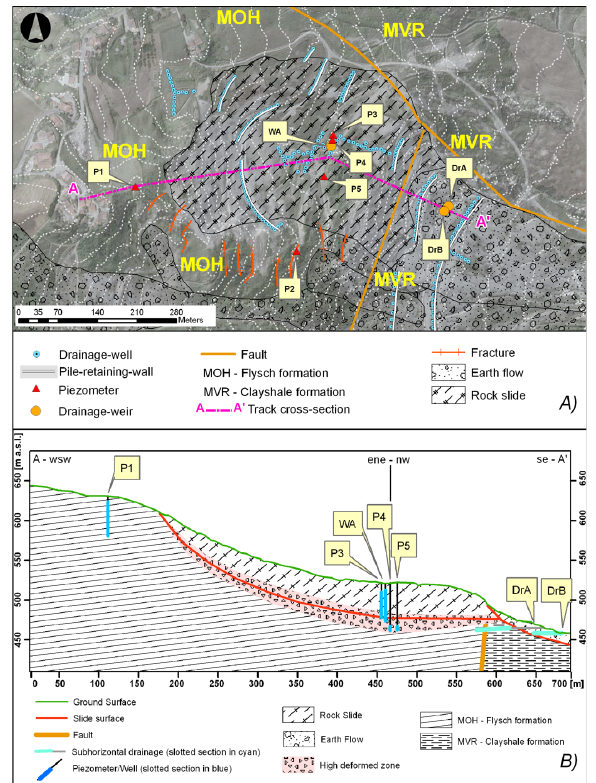
Fig. 2. (a) Geological sketch of Ca’ Lita landslide. Location of the monitoring points: drainage systems DrA, DrB, WA; piezome- ters P1, P3, P4, P5. (b) Geological cross-section of Ca’ Lita with drainage works and